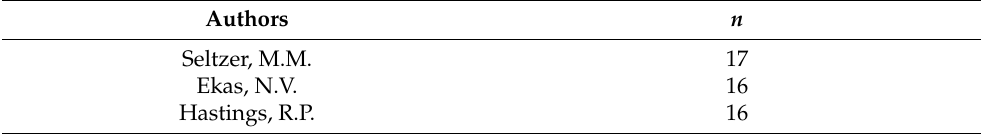
Table 6. Most prolific